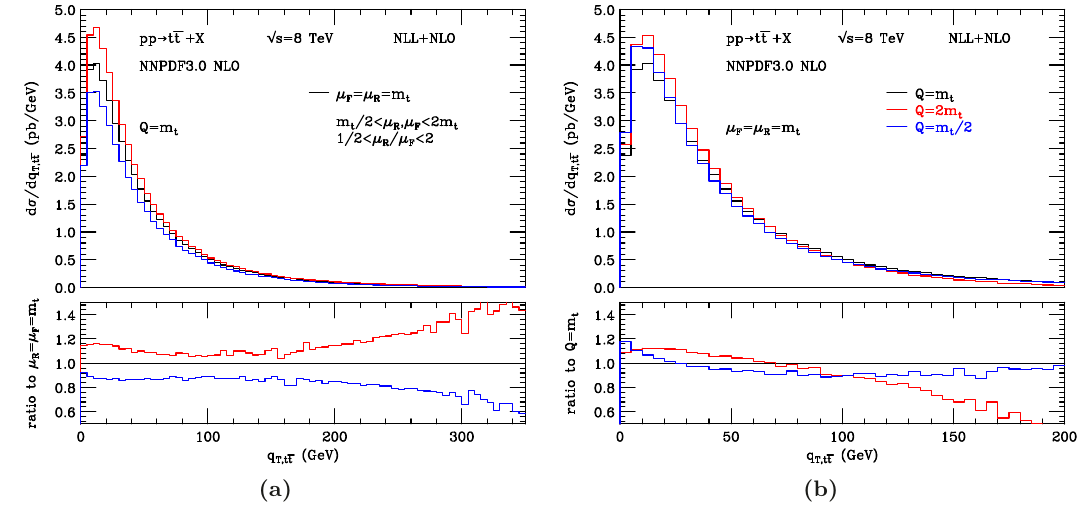
Figure 5. The transverse-momentum cross section dσ/dq T of the t ¯ t pair at the LHC ( √ s = 8 TeV) computed at NLL+NLO accuracy. The bands (blue and red lines) are obtained by varying µ F and µ R (left) and Q (right) as described in the text. The lower panels present the scale variation bands relative to the result at central scales ( µ R = µ F = Q = m t